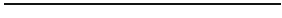
constraints on the non-unitarity parameters α from DUNE